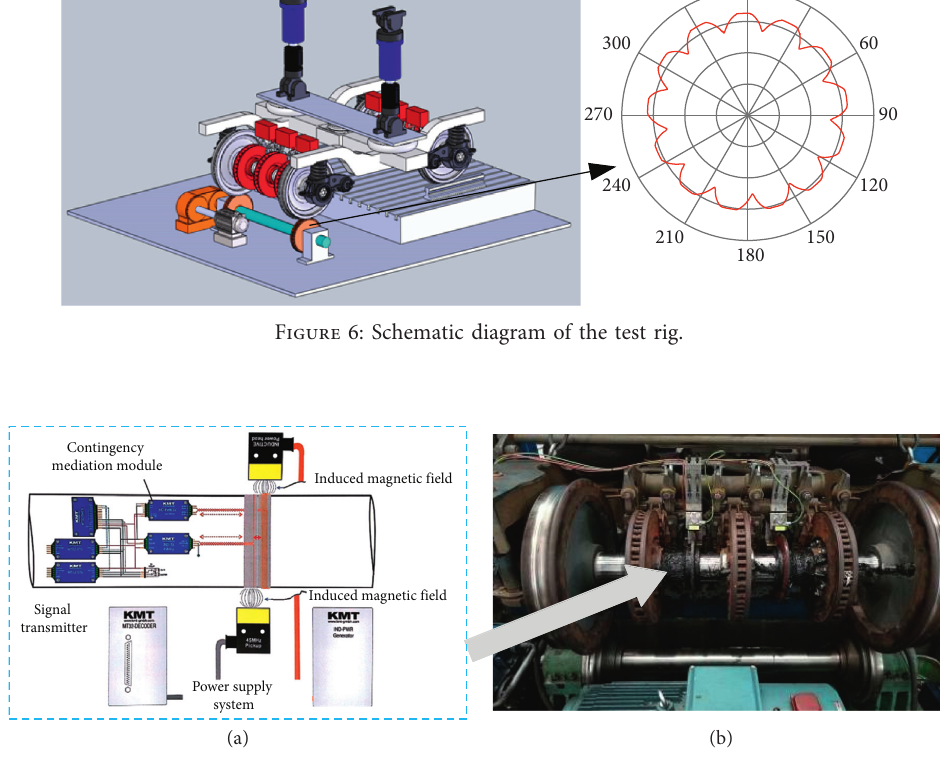
Figure 7: Dynamic stress test. (a) Principle of the data acquisition system. (b) The tested bogie on the rig.